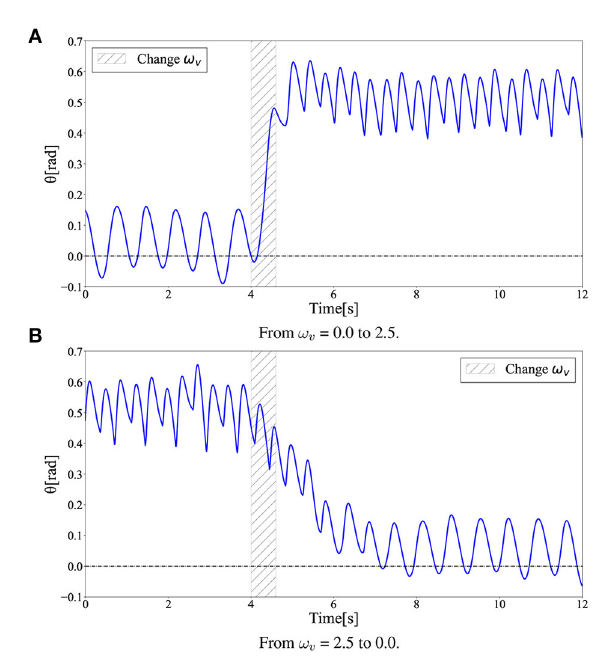
FIGURE12 Hip segment orientation ( θ ) during gait transition. The gait patterns generated by the learned policy show that the bipedal model maintained a relatively perpendicular posture to the ground ( θ when walking, while the model moved with a forward leaning posture ( θ > 0) when running. (A) From ω v = 0.0 to 2.5. (B) From ω v = 2.5 to